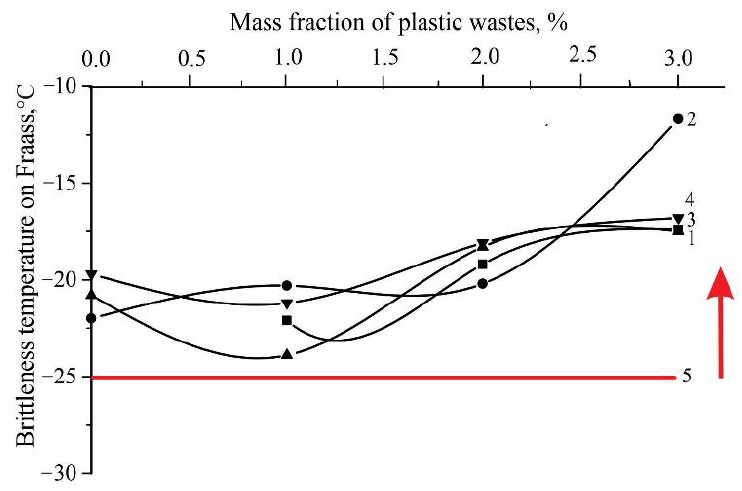
Figure 6. Change in brittleness temperature on Fraas from polymer waste concentrations. 1—without SBS; 2—SBS 1%; 3—SBS 2%; 4—SBS 3%; 5—according to Standard.